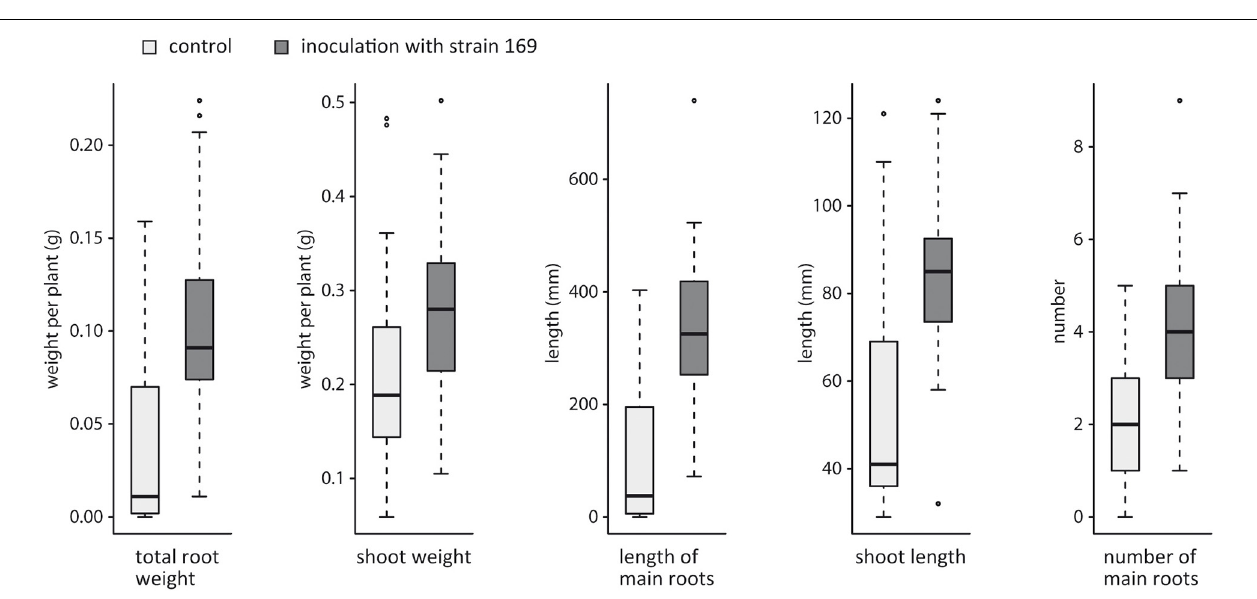
FIGURE 2 | Effects of strain 169 on root and shoot development of the hybrid poplar clone 741 in vitro . All measured parameters were significantly increased in the inoculated plants ( p < 0.0001, Wilcoxon rank sum